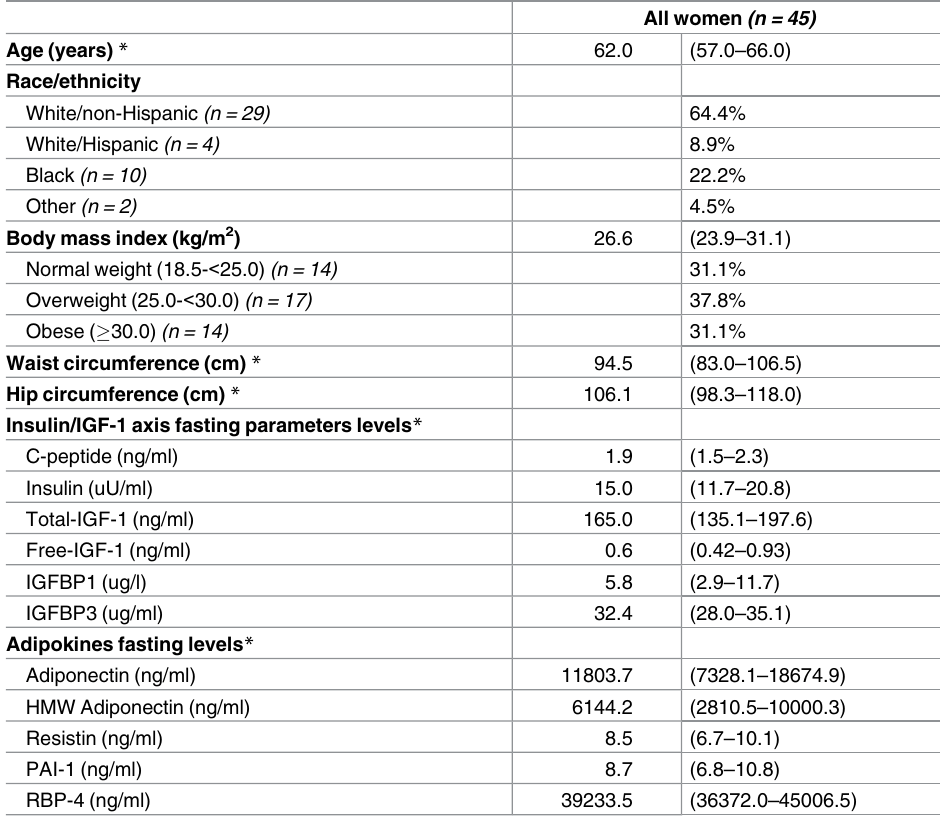
Table 1. Characteristics of study subjects.